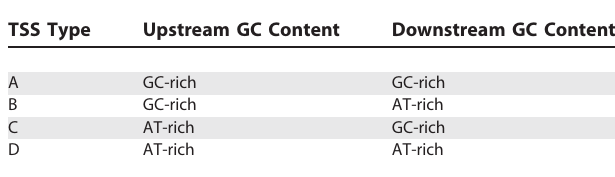
Table 1. Four TSS Types Defined Based on the GC Content Upstream and Downstream of the TSS